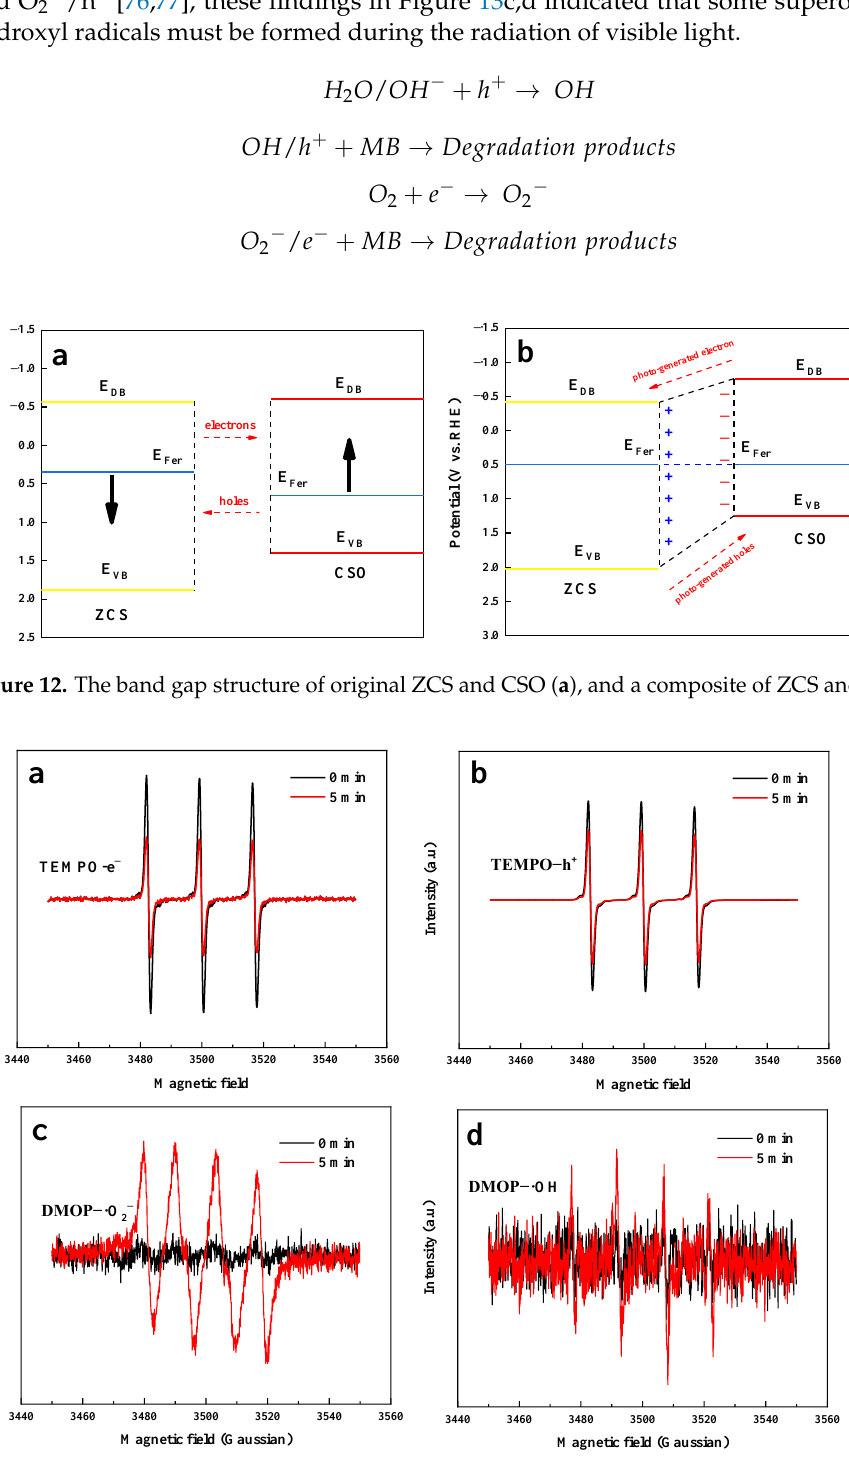
Figure 13. The ESR spectra of ZCS/1CSO under dark (0 min) and visible light (5 min), ( a ): TEMPO-e − , ( b ): TEMPO-h + , ( c ): DMOP-O 2 − and ( d ): DMOP-OH.